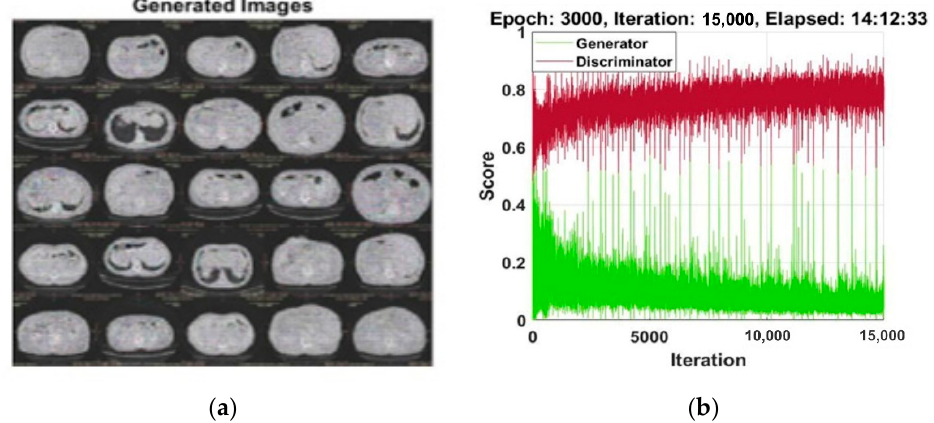
Figure 6. Training model performance ( a ) synthetic generated images ( b ) prediction scores (where red line shows discriminator scores and the green line represents the loss rate).